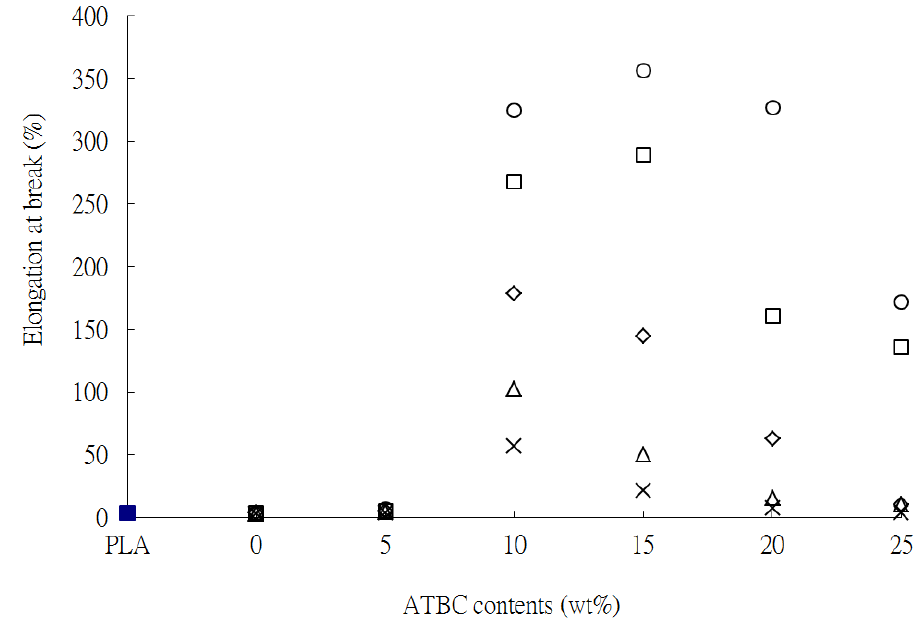
tapioca MDI ; ( ◇ ) PLA 80 20 0.5 tapioca MDI 50 50 0.5